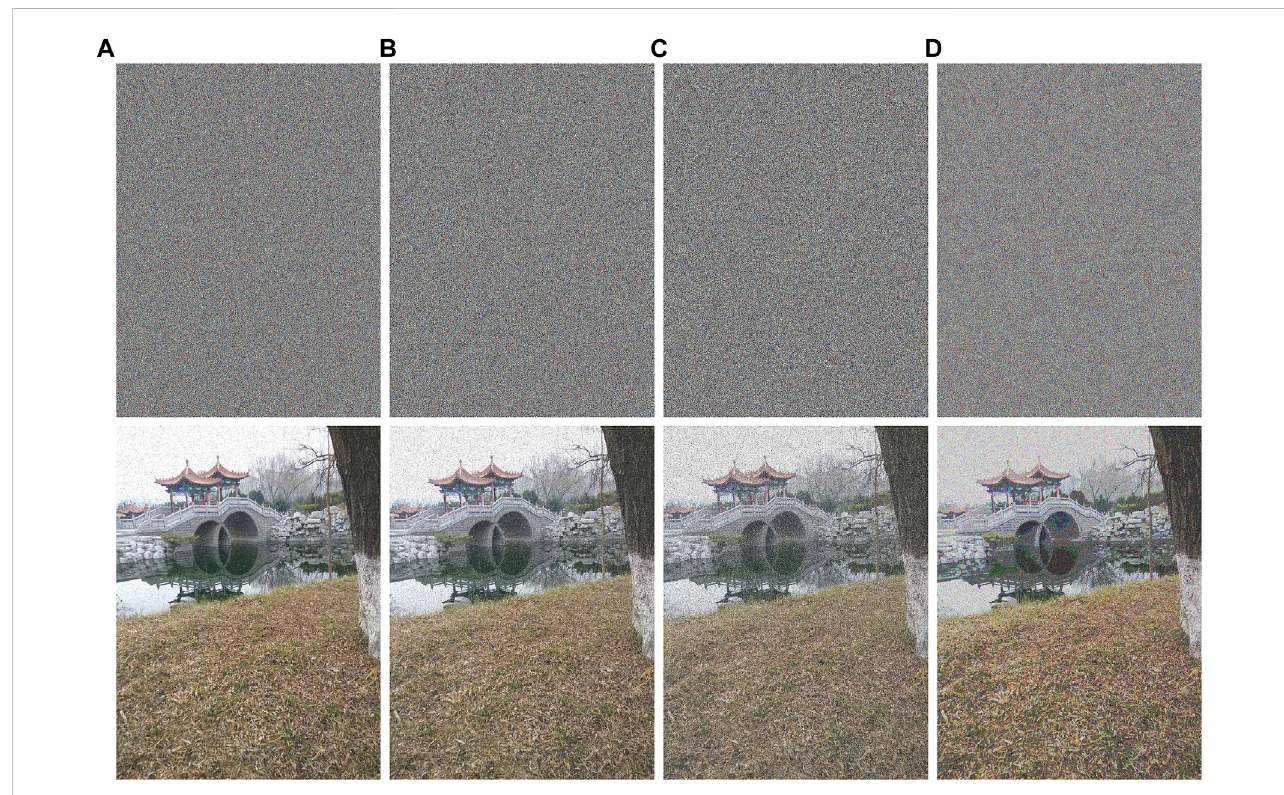
FIGURE 7 Noise attack: (A) is the decryption result of adding 5% salt noise, (B) is the decryption result of adding 5% salt noise, (C) is the decryption result of adding 35% salt noise, and (D) is the decryption result of adding 1% gauss